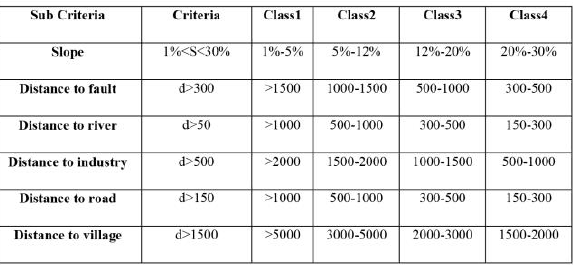
Figure 3. The influencing criteria and sub-criteria in location finding problem of the future city developments of Zanjan. Table 1. Constraints and their corresponding values for sub- criteria (Class 1 is the best value and Class 4 shows the worst), The unit of slope is percentage and the distances in